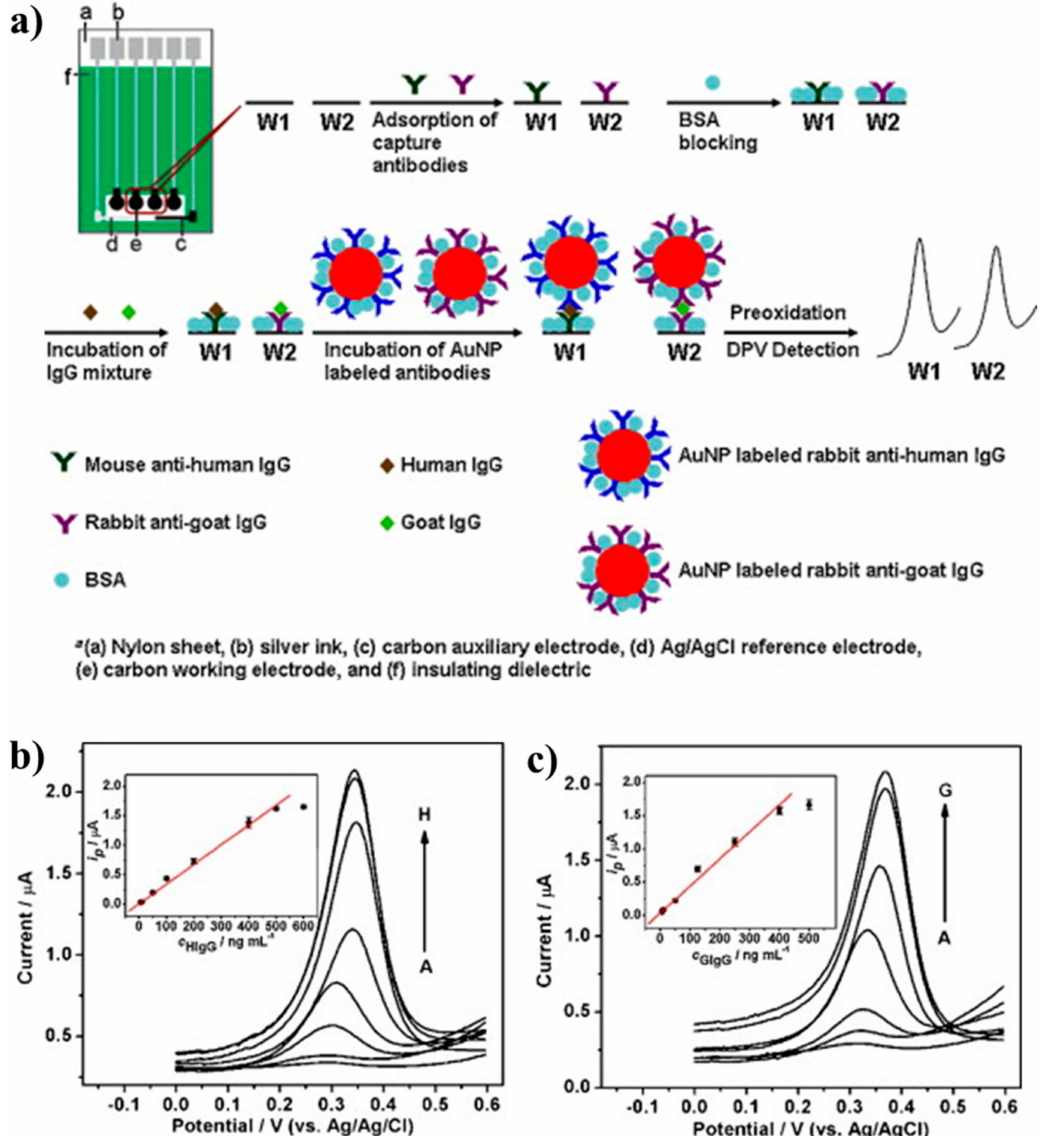
Figure 4. ( a ) Schematics of the preparation of immunosensor array for the simultaneous detection of HIgG and GIgG. ( b ) DPV responses for the simultaneous multiplexed detection of HIgG (5–600 ng/mL), and ( c ) GIgG (5–500 ng/mL) using Au NPs as a label. Insets show the corresponding calibration curves. Reproduced with permission from reference